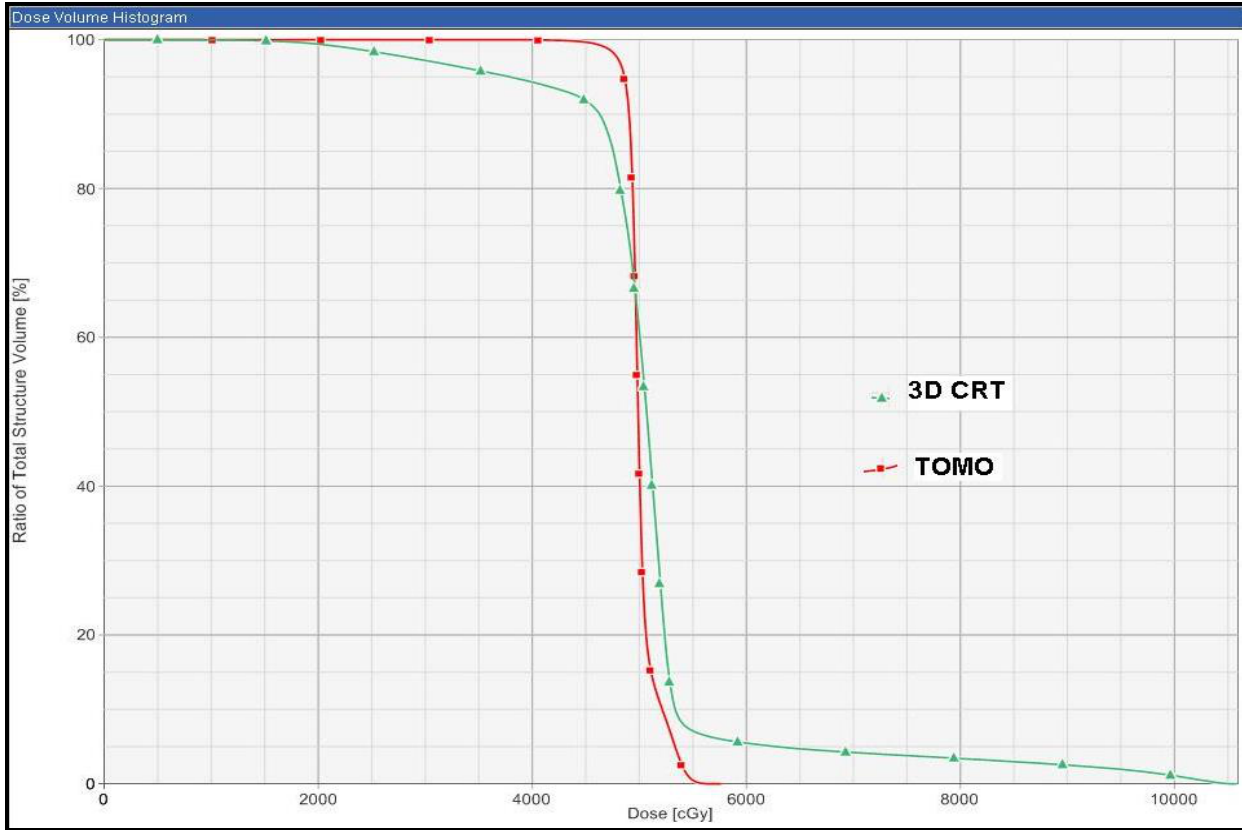
Figure 2: Chest wall planning target volume coverage comparison between the 3D-CRT and HT